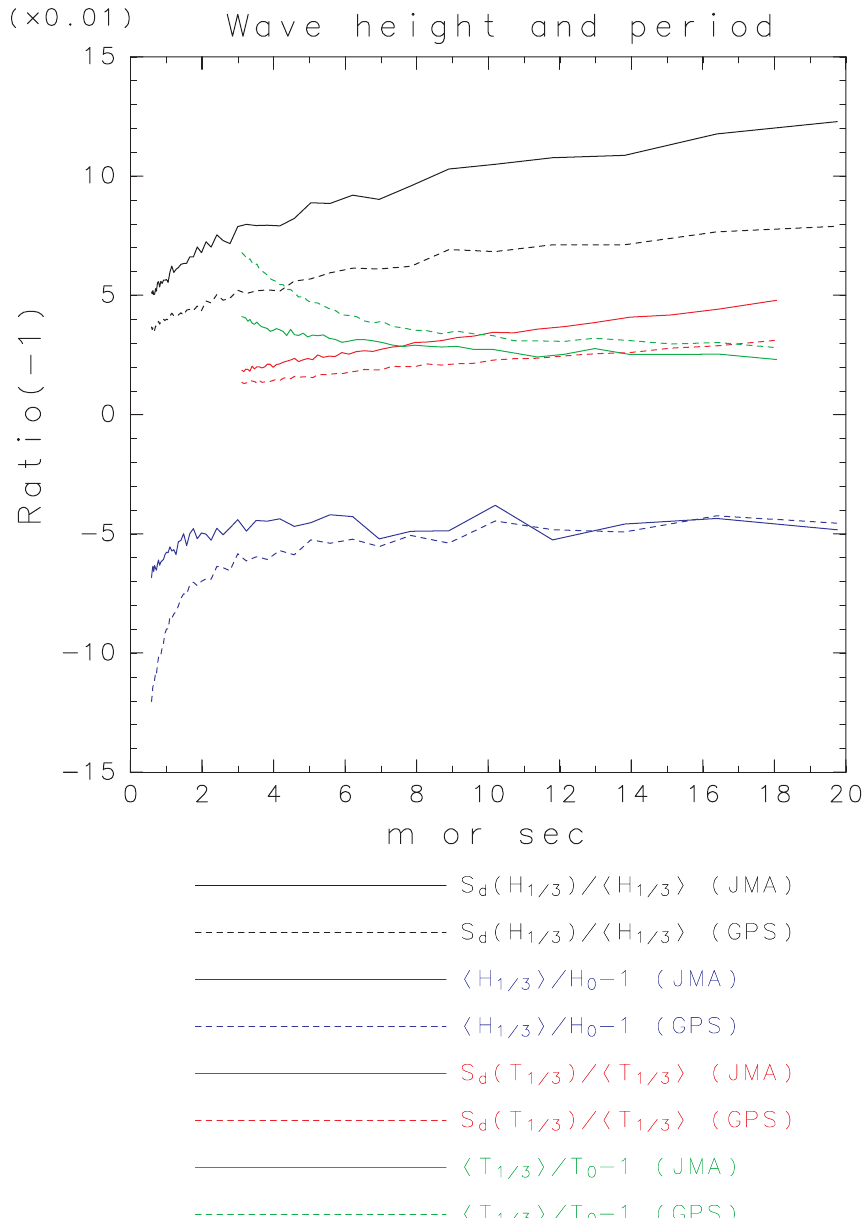
Figure A1. Black: Normalized standard deviations of the significant wave heights ( S d ( H 1/3 ) 1 ) versus the ensemble mean significant wave heights (horizontal axis: H 1/3 (cid:104) (cid:105) − by the method in Appendix A. Blue: Simulated values of as the black line, but for the wave periods (horizontal axis: 1 / T 0 1 ( T 0 = M ). The solid lines are those for the JMA drifting buoys, while the dashed T 1/3 1 M − 0 (cid:104) (cid:105) − − lines are those for the GPS